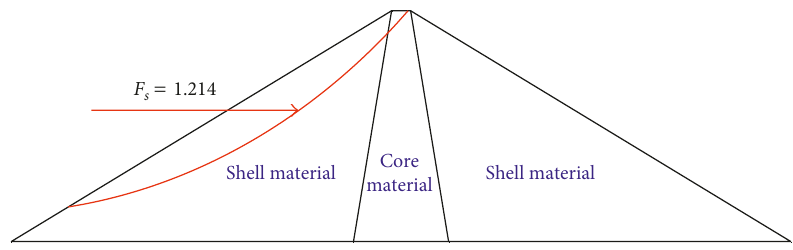
Figure 4: Potential circular slip surface and factor of safety of dam under design earthquake.